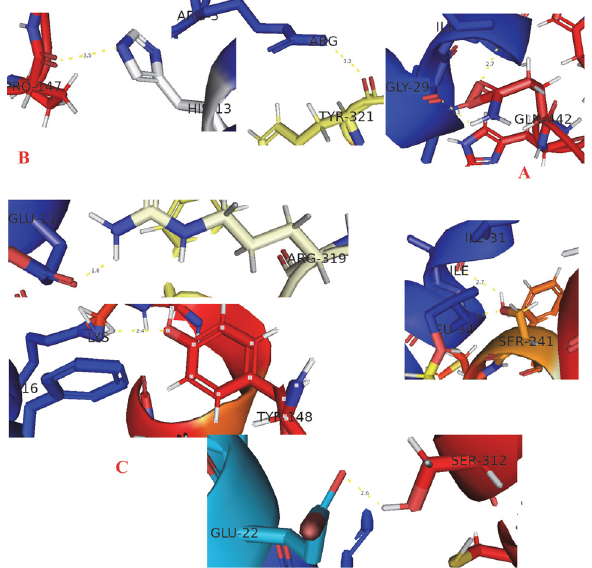
Figure 8. The FRODOCK2 model result of Aggregatin and Aβ42 peptides. Binding modes of Aggregatin and Aβ42 in surface rep- resentations are shown. A.) Aggregatin(GLN442) interacts with the residue GLN29 and ILE32 of Aβ. B.) Aggregatin(TRY321) interacts with ARG5, PRO147 with HIS13. C.) Aggregatin(TYR148) inter- acts with LYS16, ARG319 with GLU11, and SER312 with GLU22, and SER241 with ILE31/LEU34. In this binding mode of the simu- lation, GLU11, LYS16, and GLU22(of section A) and ARG5, and HIS13(of section B) are in the N-terminal domain of Aβ1-42 pep- tide whereas GLY29, ILE32, and ILE31, and LEU34 (of section C) are in the C-terminal domain of Aβ 42 .